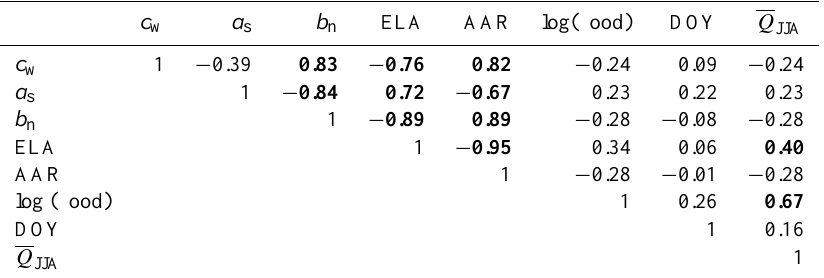
Table 9. Correlations between the annual winter ( c w ), summer ( a s ), net balance ( b n ), equilibrium line altitude (ELA), and accumulation area ratio (AAR) estimates of Storglaci¨aren and the annual maximum flood peaks (log(flood)), flood occurrences (DOY), and mean summer discharge ( Q JJA ) for the Tarfala catchment for the comparison period 1985–2009. Correlations that are significant at the 5% significance level for a 2-sided test are indicated in